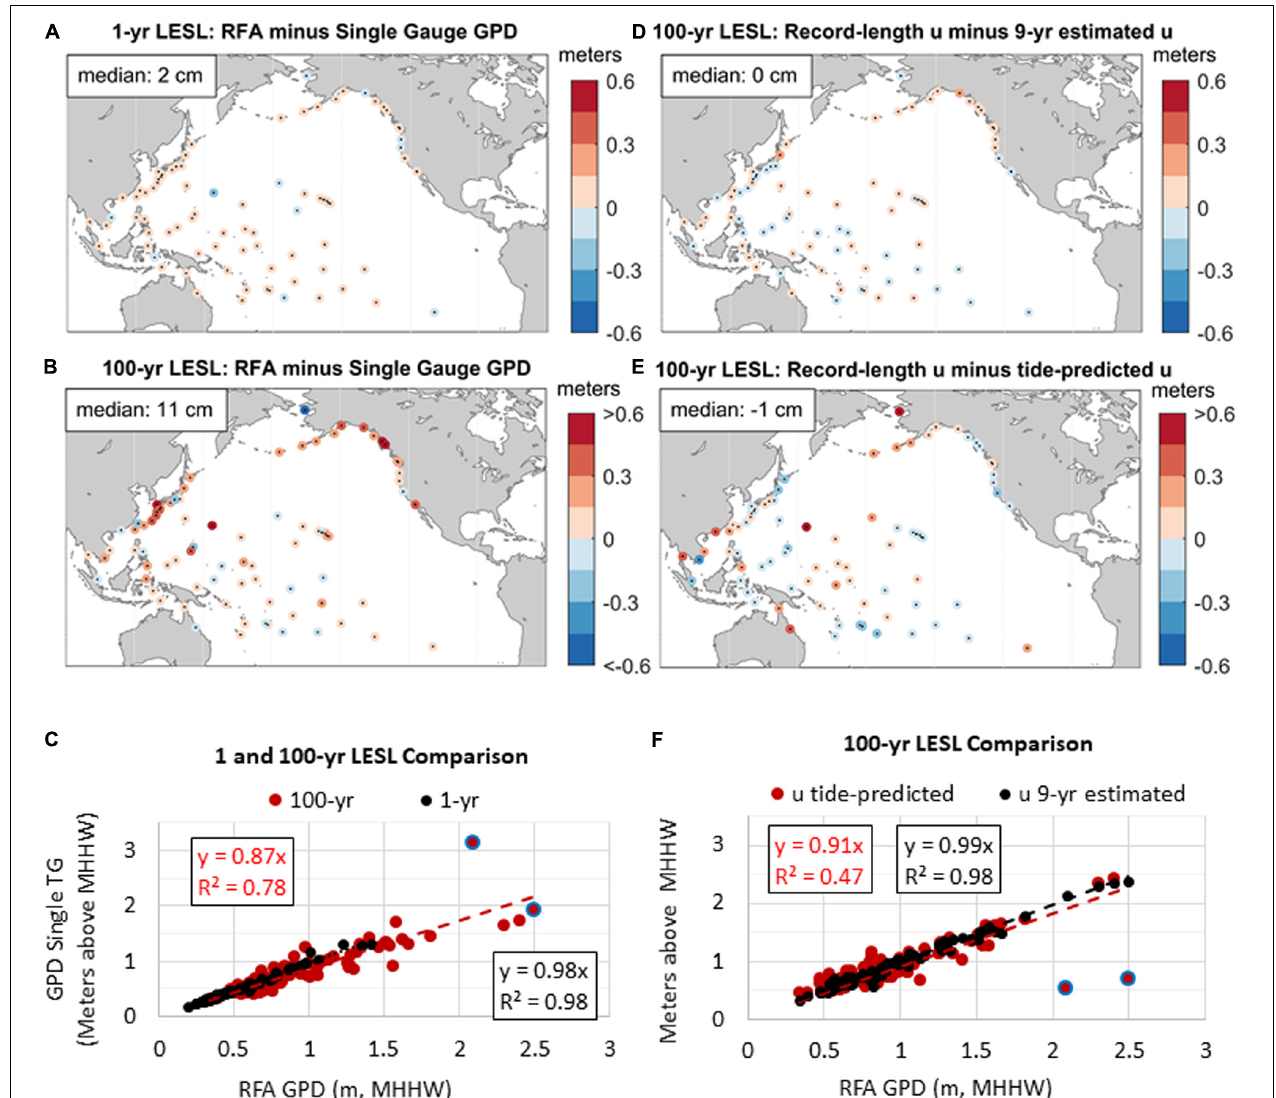
FIGURE 6 | Differences in the RFA LESLs and those computed using a single TG only at the (A) 1-year and (B) 100-year levels and (C) linear regression between the sets in (A,B) . Mapped differences in the 100-year LESLs using record length u and (D) 9-year (2011–2019) estimates and (E) a tide-range based predictions of u plotted with linear regression statistics in (F) . The outliers (blue circles) are included in the regressions in plot (C,F)